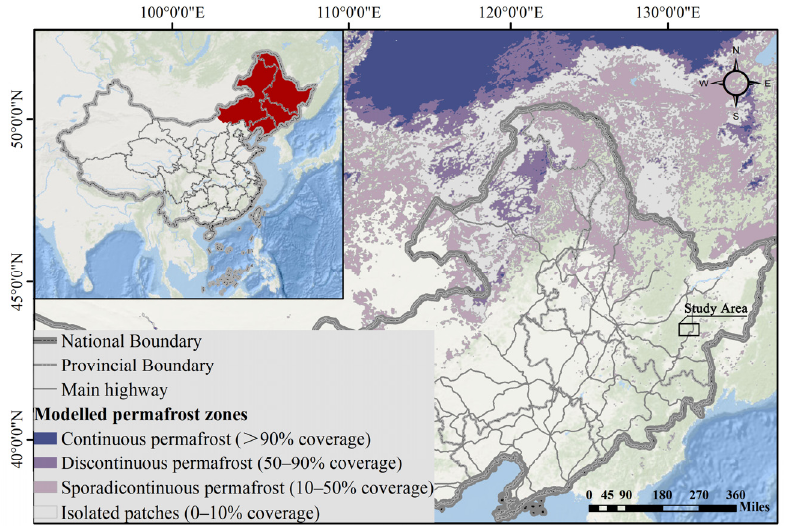
Figure 1. Distribution of permafrost in Northeast China and the project location of the study area.